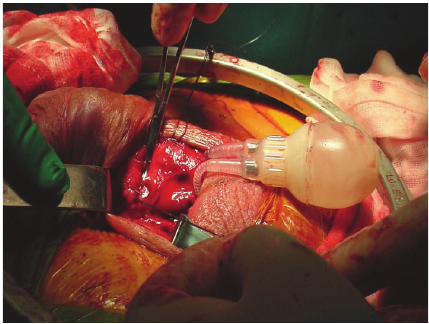
Figure 2: The first row of plication sutures, placed before insertion of the penile prosthesis, is tied.